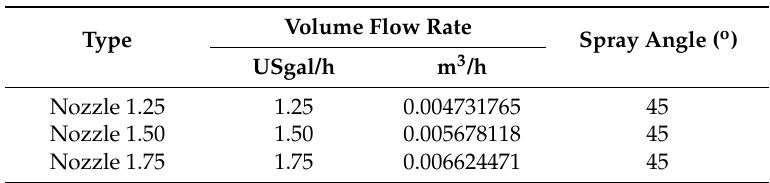
Table 3. Nozzle flow rates.